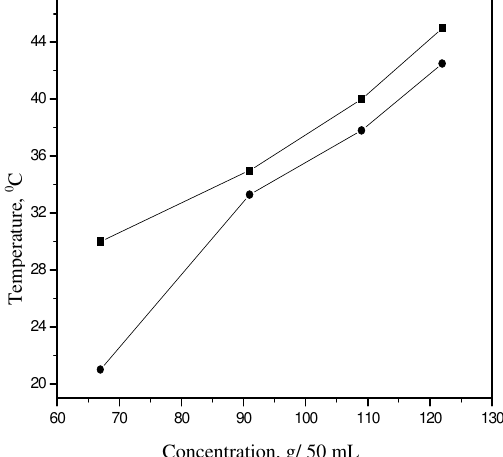
Figure 2. Meta stable zone width as a function of temperature in aqueous